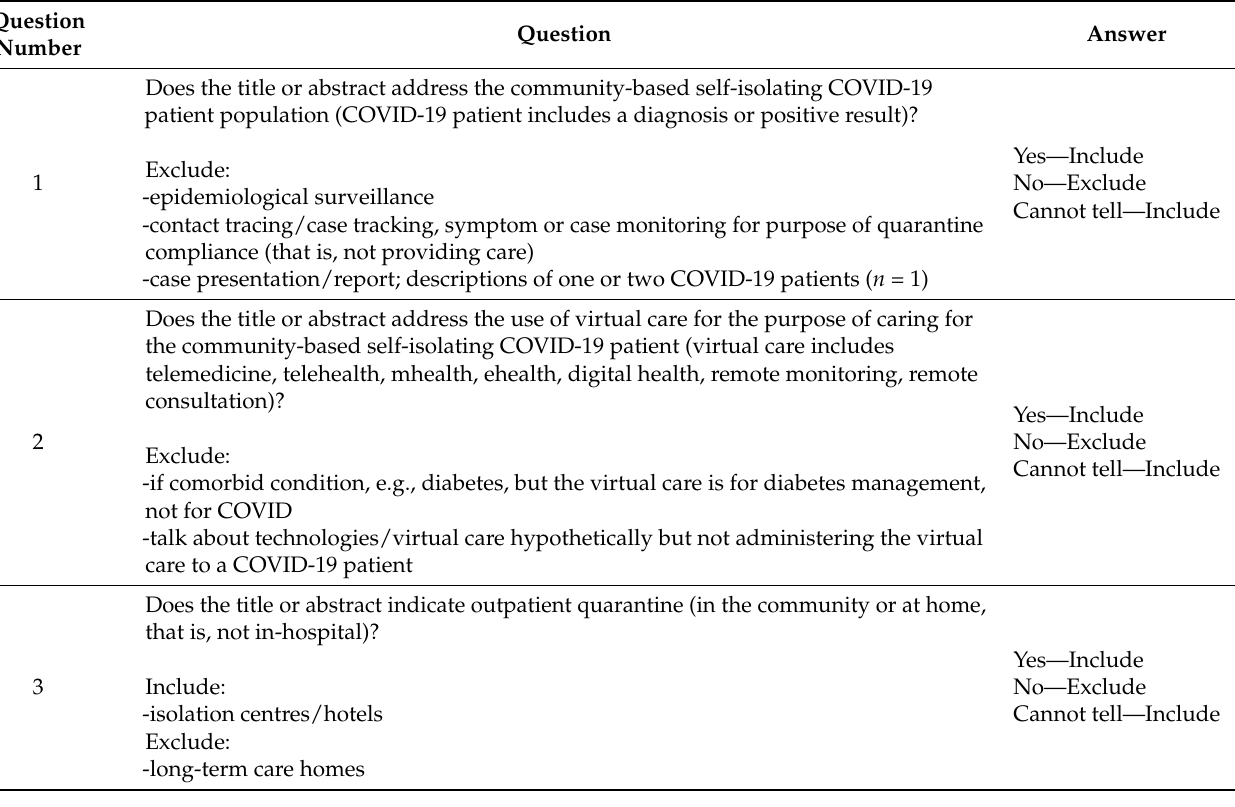
Table 2. Level 1 Eligibility Screening